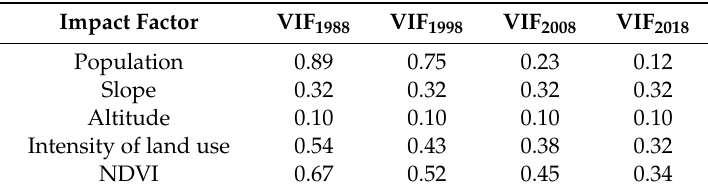
Table 14. Multicollinearity of impact factor variance inflation factor (VIF).